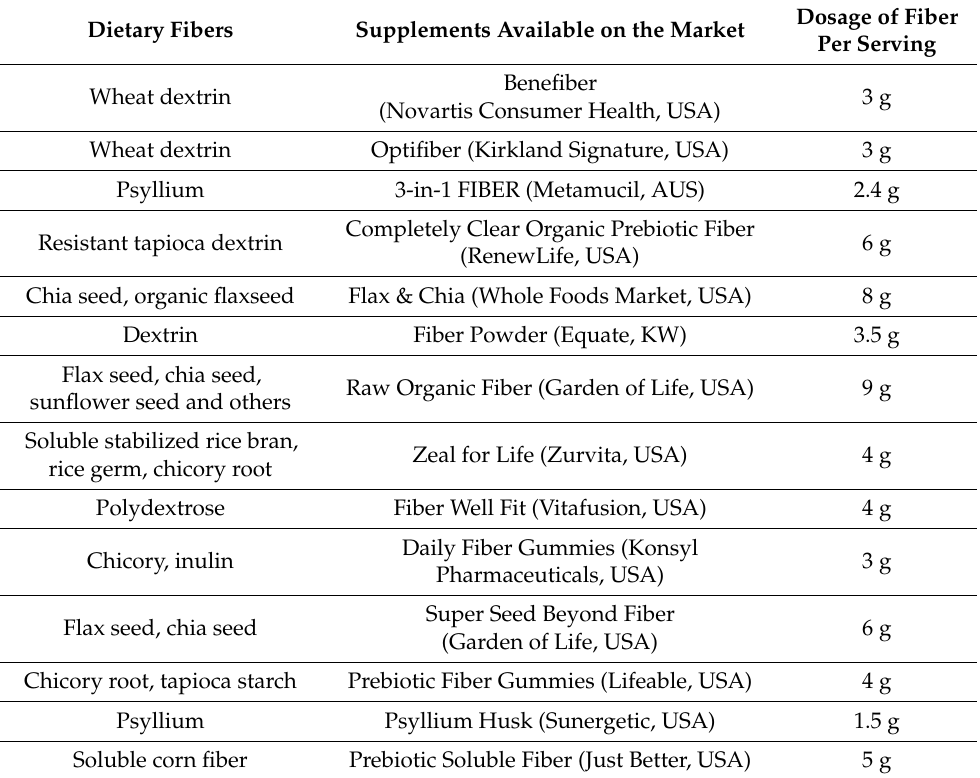
Table 2. Supplements containing dietary fibers available on the market. Dietary